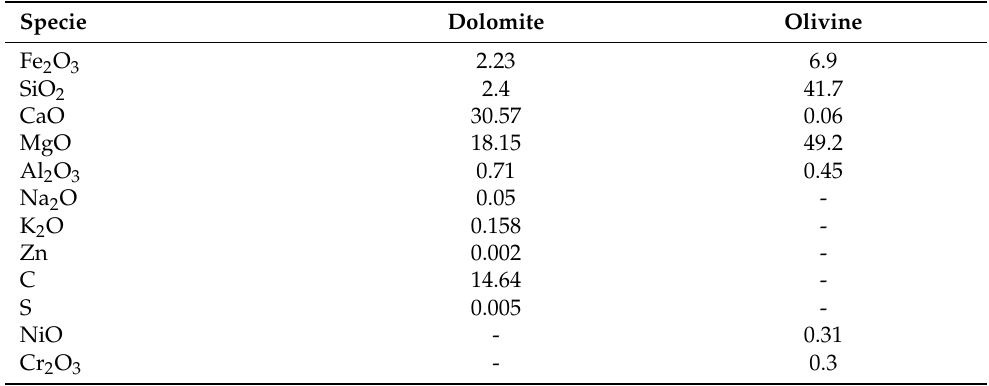
Table 2. Chemical composition of dolomite and olivine